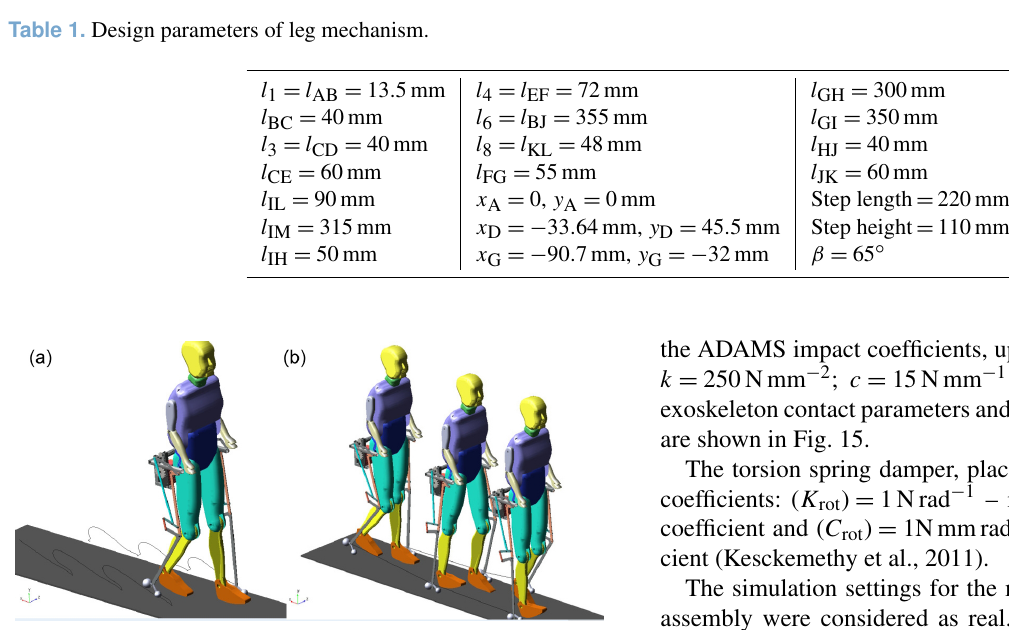
Figure 16. Snapshots of simulation outputs of the exoskeleton and mannequin